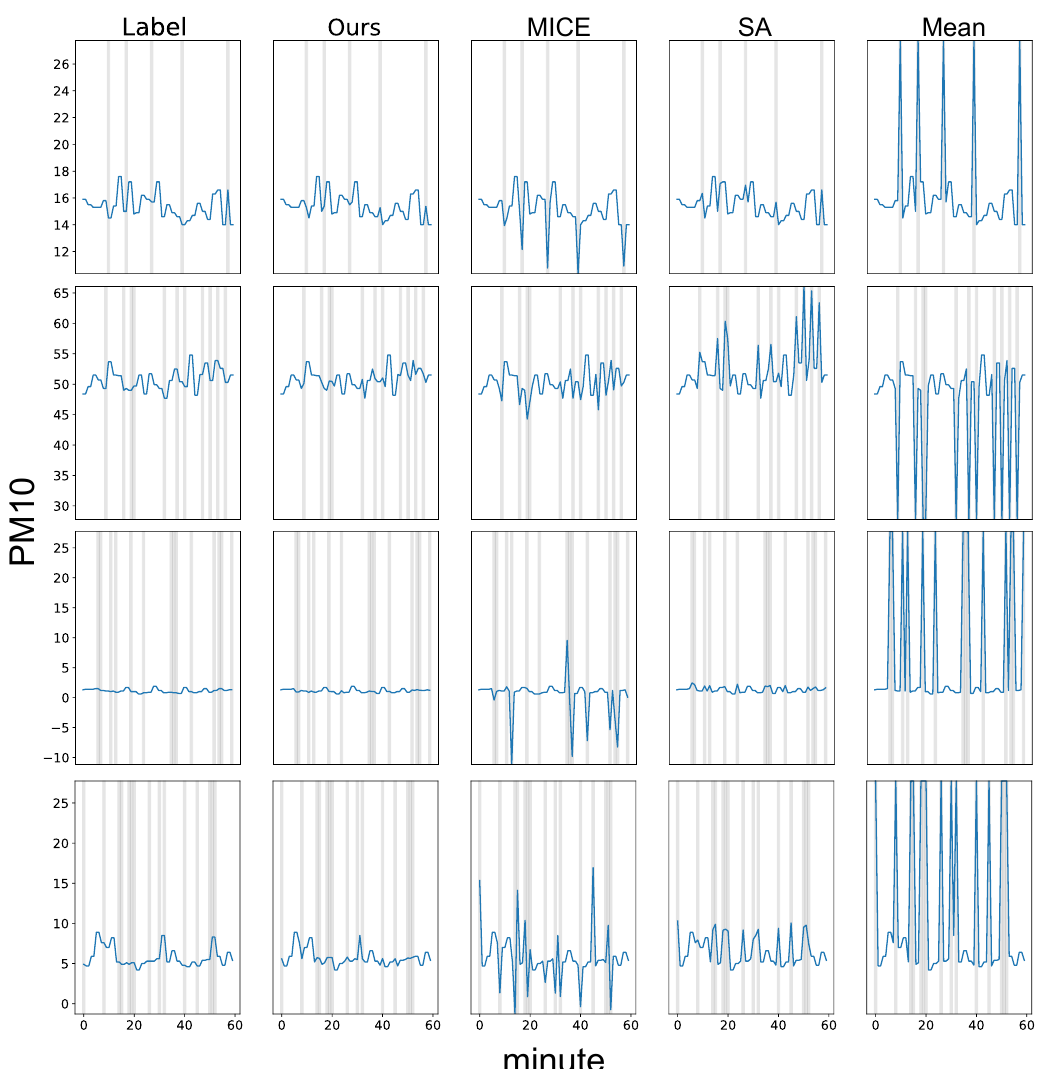
Figure 3. Qualitative time-series imputation results of our method in comparison with baseline models. The results are obtained with PM 10 test data collected at Guro-gu. We mark the missing values in the input as gray background. For all the compared models, the non-missing values (white background) are the same as the label. Label denotes the original time-series without missing values. SA indicates the spatial average value imputation